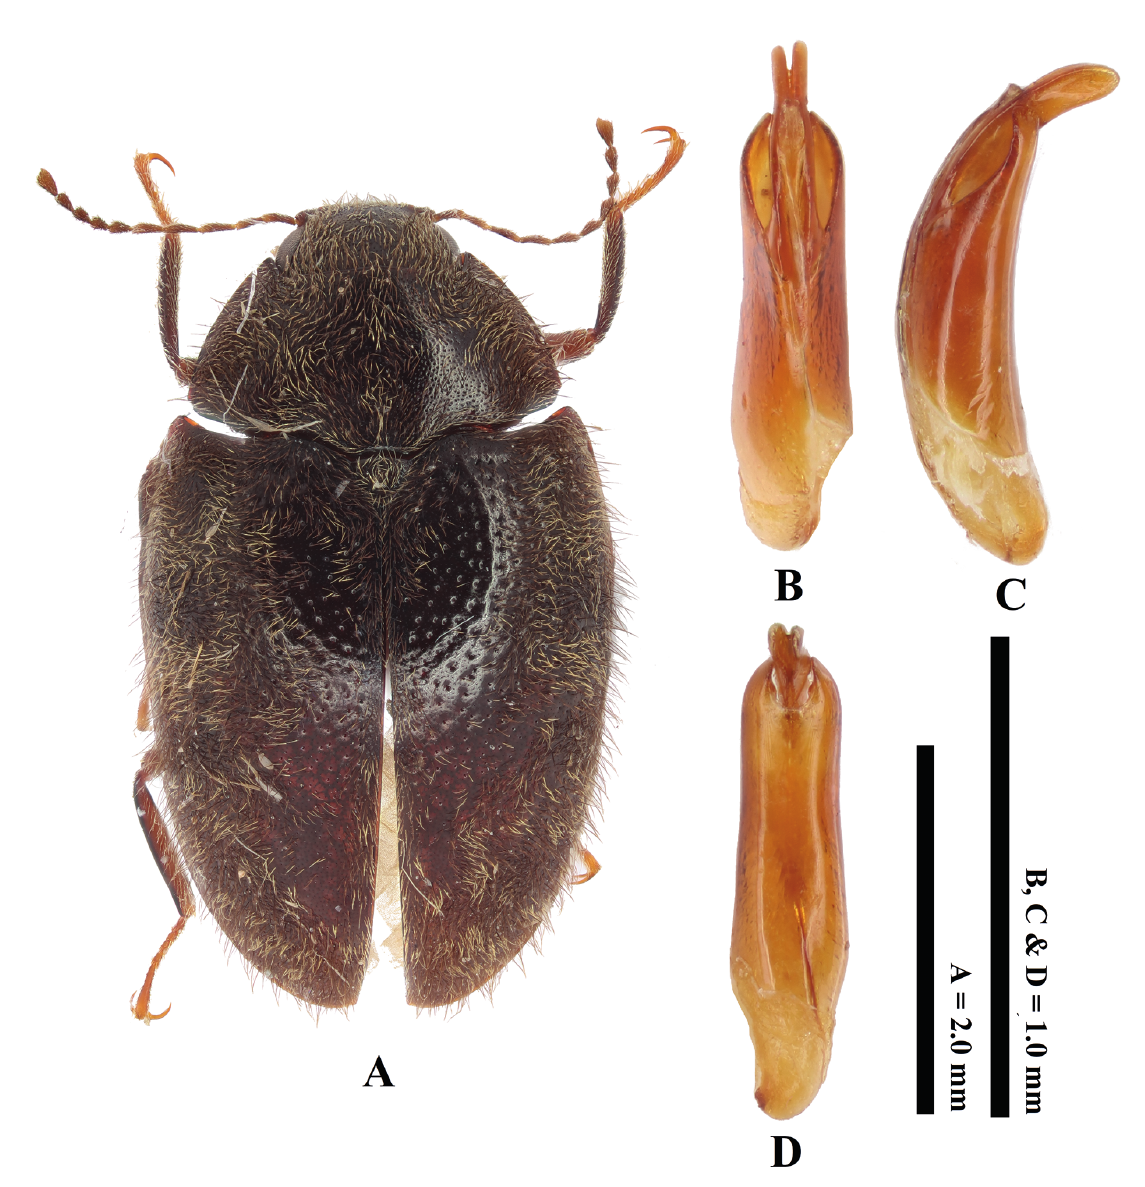
Fig. 6. Caccothryptus abboti sp. nov., ♂, holotype (NHMUK011225275). A . Dorsal habitus. B . Genitalia, dorsal. C . Genitalia, lateral. D . Genitalia,